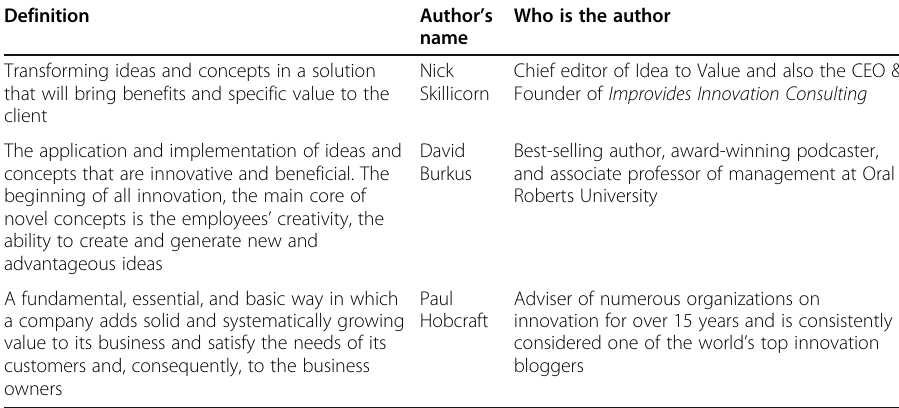
Table 1 Definition of innovation from business practitioners